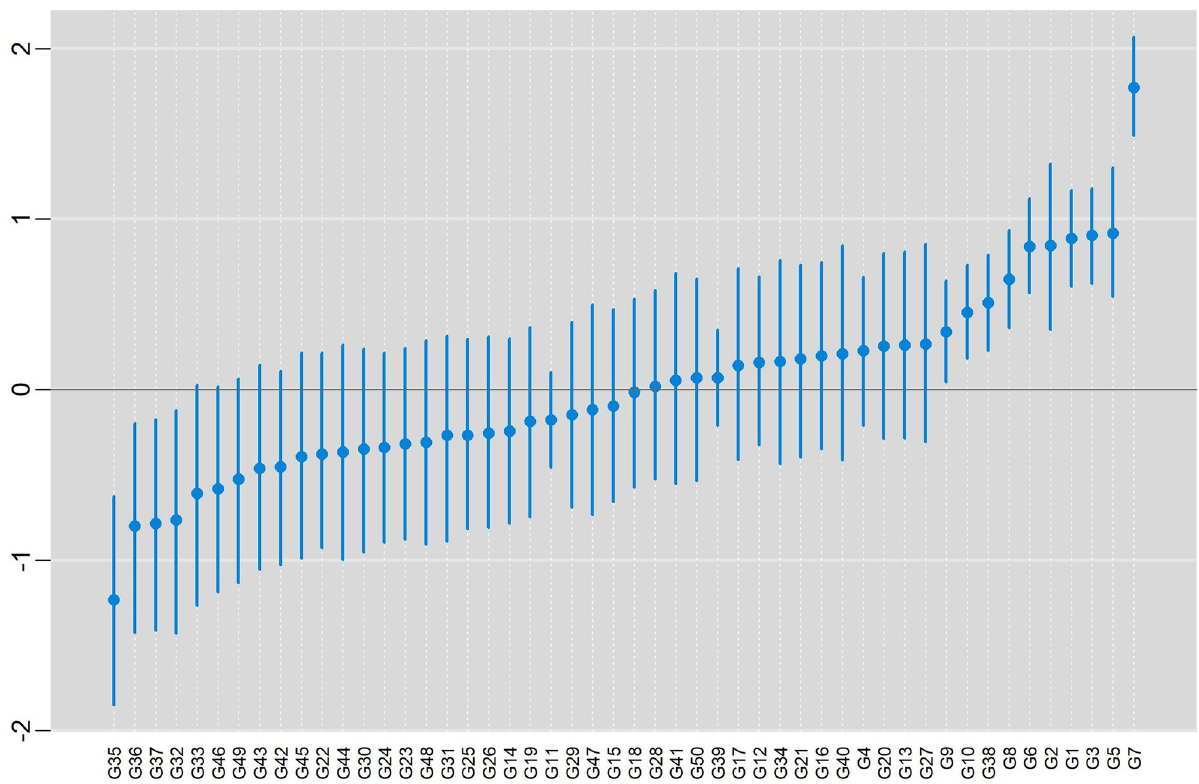
Fig 17. Posterior means and the 95% HPD intervals for the effect of genotypes, considering the BAMMIS-3 model, for real data using the MCMC method.